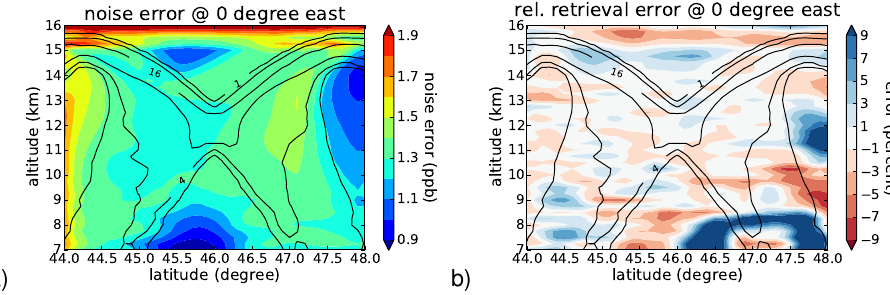
Fig. 17. The retrieval result of a run with advection and perfect a priori knowledge thereof. Panel (a) shows the error induced by noise according to the linearised diagnostics at 0 ◦ E while panel (b) depicts the relative error in percent compared to the true values. The number of tangent points within the depicted volume elements is overlaid as a contour plot.